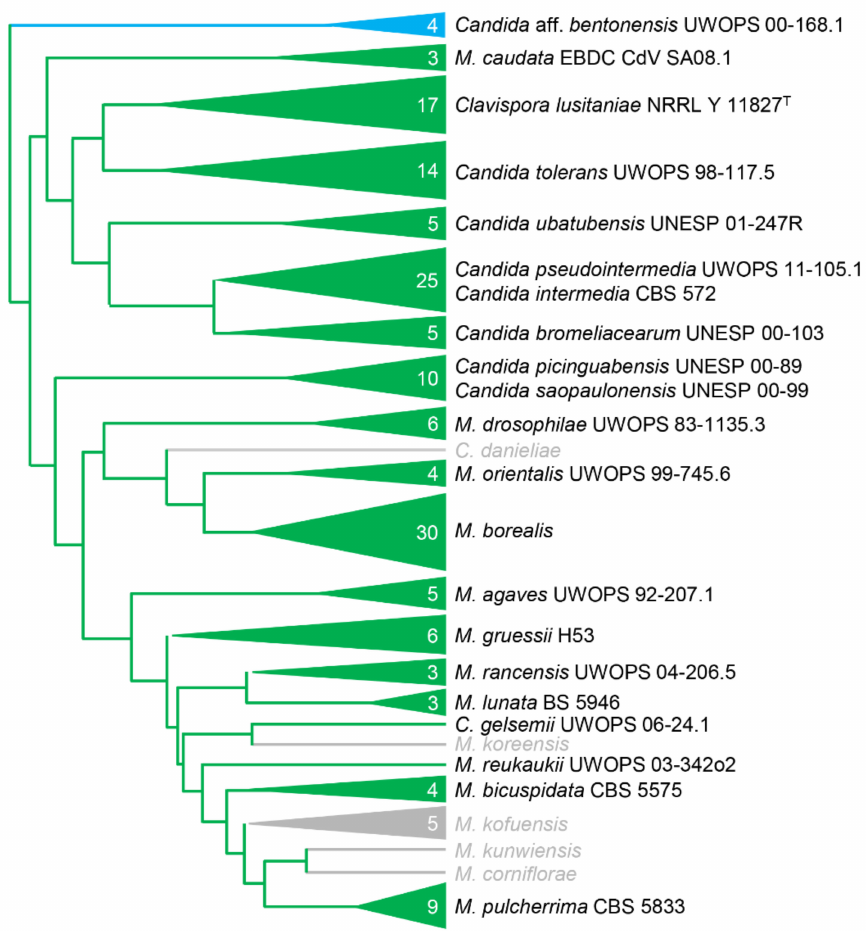
Figure 4. A phylogeny of the Metschnikowiaceae, modified from Lachance (2016) [5], showing the taxonomic range of successful transformations in the family. Representative strains